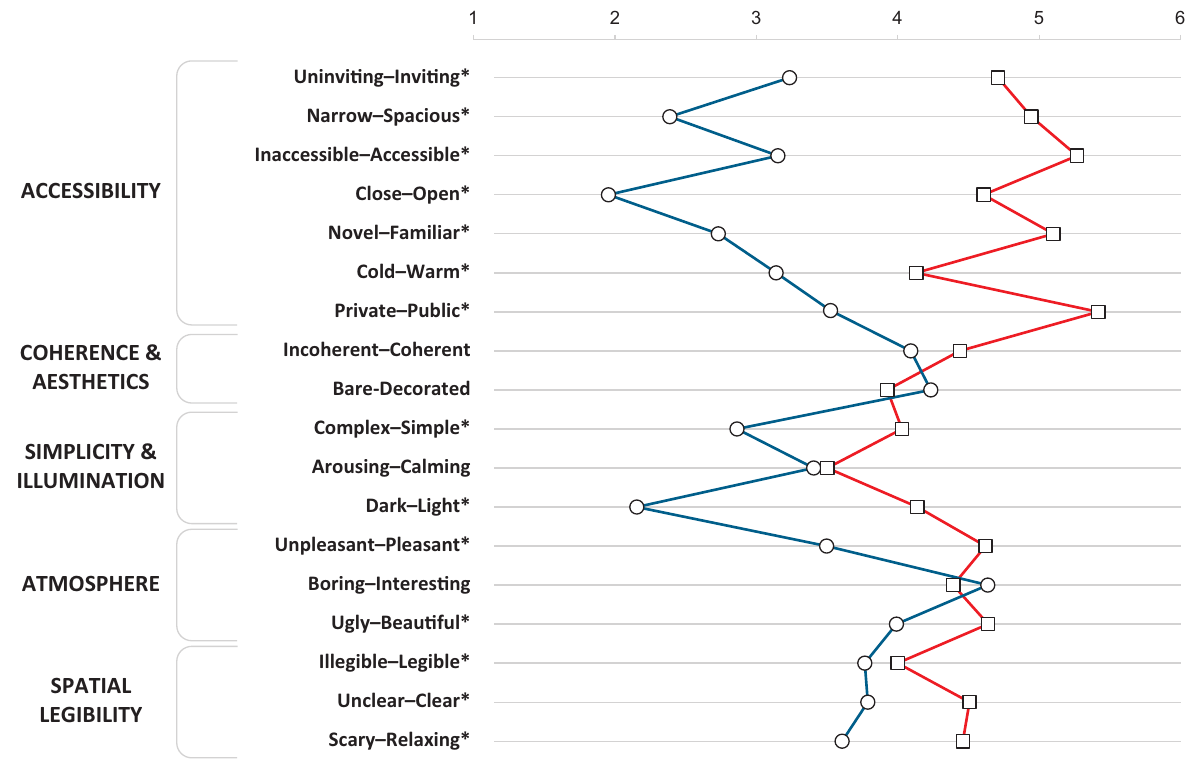
Figure 2. Augmented (blue) and non‐augmented (red) spatial perception. Note: * = mean comparison